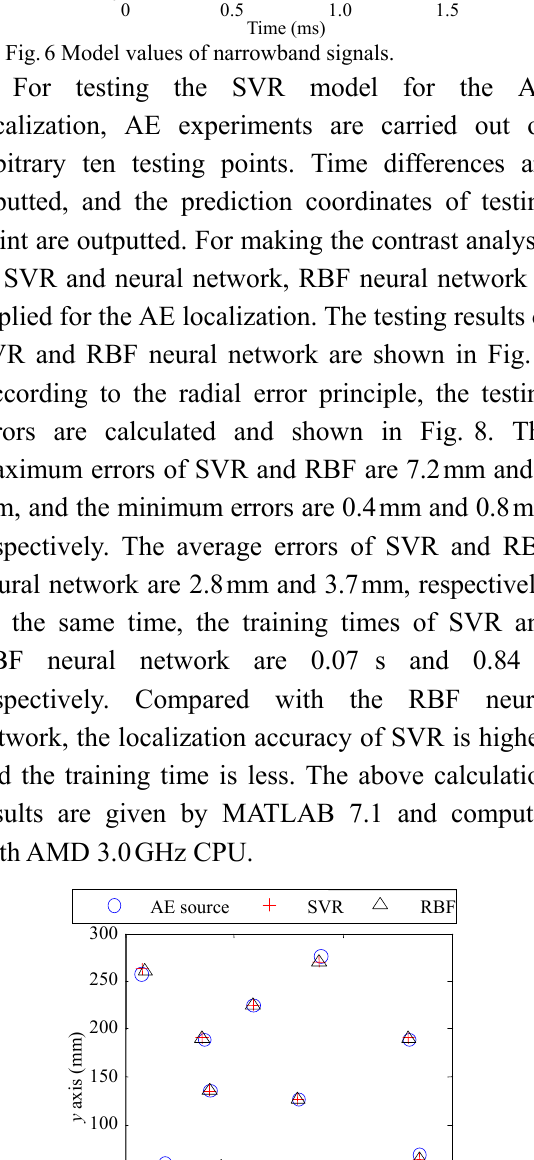
Fig. 7 Result of testing